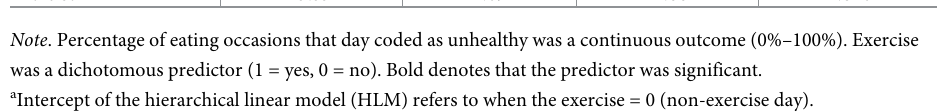
Table 5. Exercise as a predictor of the percentage of unhealthy meals in a day (Study 2). b SE t p Exercise